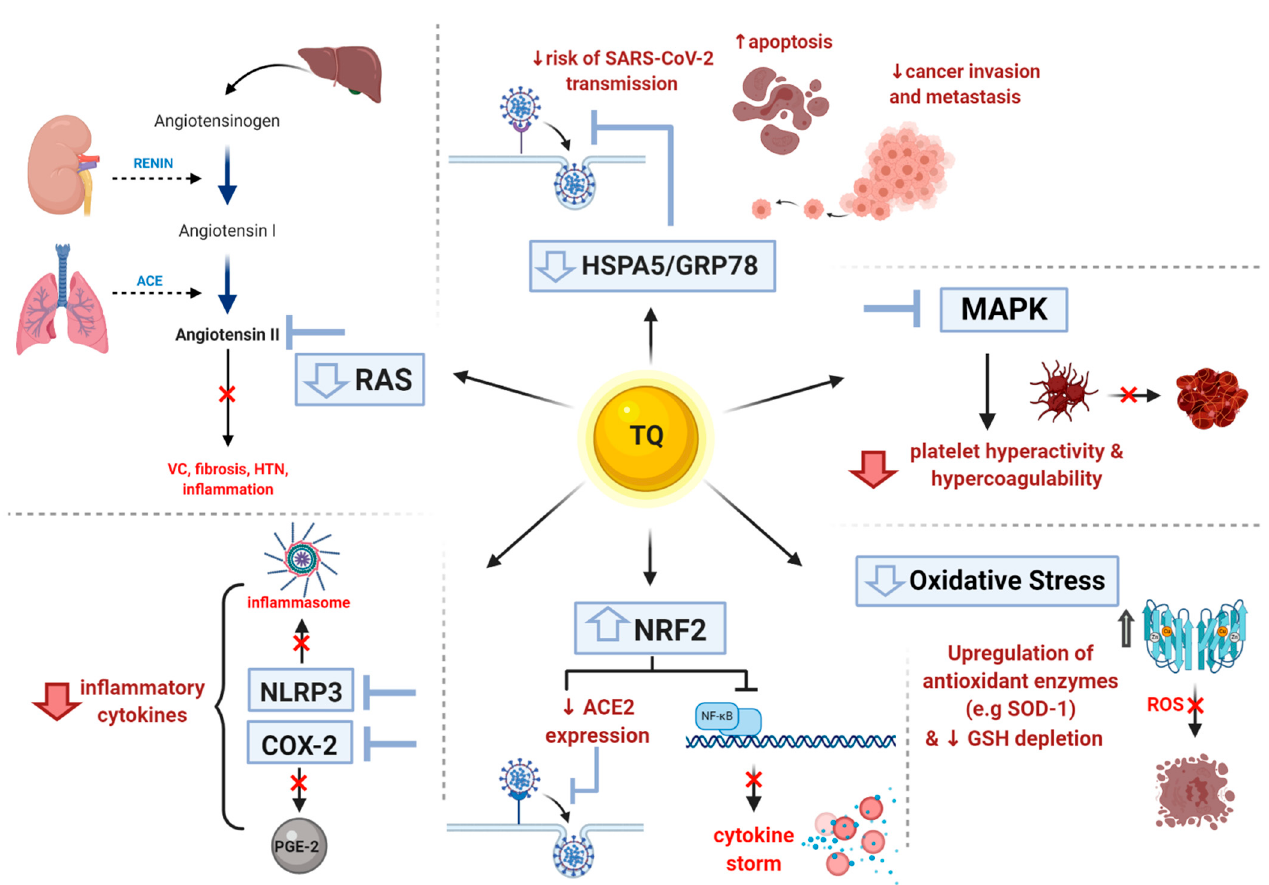
Figure 4. TQ common effects in SARS-CoV-2 infection and cancer. The figure summarizes TQ’s actions on molecular targets that cause beneficial outcomes in both SARS-CoV-2 infection and cancer pathogenesis.